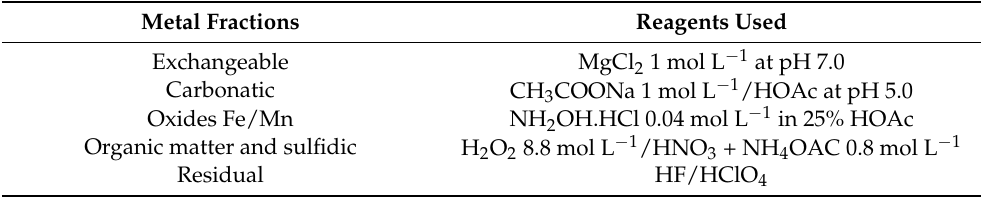
Table 6. Tessier’s scheme for the sequential extraction of metals